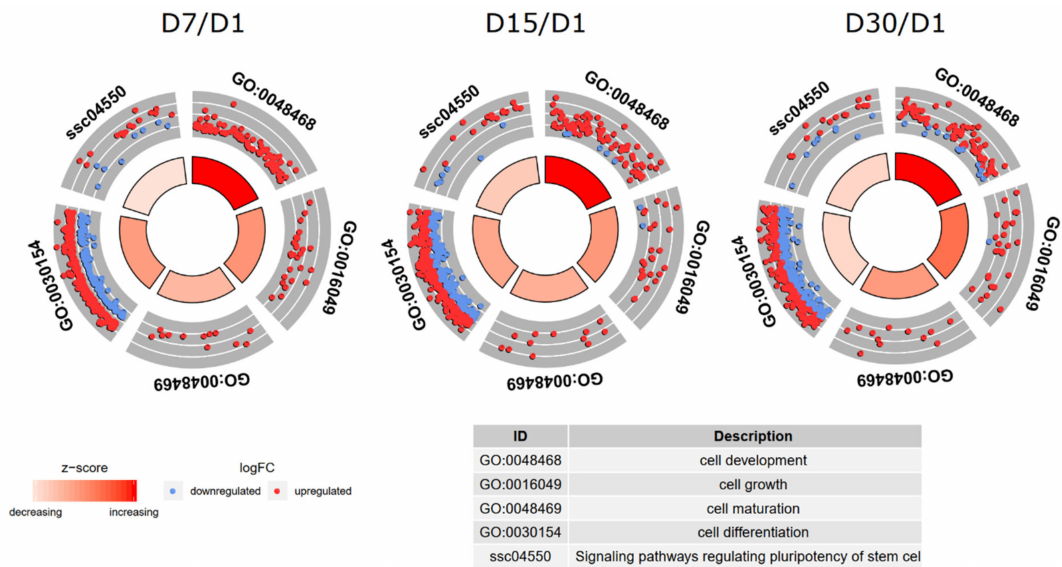
Figure 3. Circle plot showing the differently expressed genes and z-score ‘cell differentiation’, ‘cell growth’, ‘cell maturation’ and ‘cell development’ GO BP terms, as well as ‘signaling pathways regulating pluripotency of stem cells’ Kyoto Encyclope- dia of Genes and Genomes pathway. The outer circle is a scatter plot, showing fold changes of every investigated gene of the given GO. The colored dots show the decrease (blue) and increase (red) of regulation. The central columns display the z-score of every GO BP and the width of every bar expresses to the amount of genes within GO BP term. GO, Gene Ontology; BP, biological process; FC, fold change; D, day of culture.